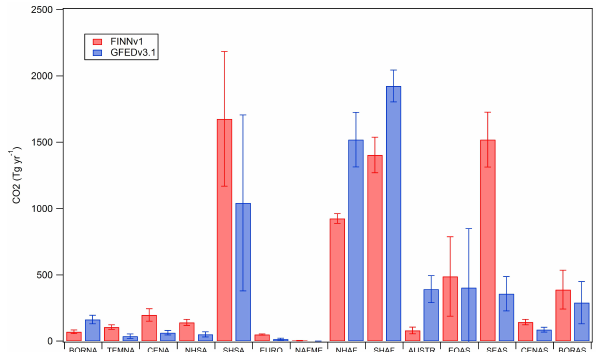
Fig. 3. Annual average CO 2 emissions (2005–2009) for FINNv1 and GFED3.1 for regions shown in Fig. 1. Error bars represent the standard deviation of the annual